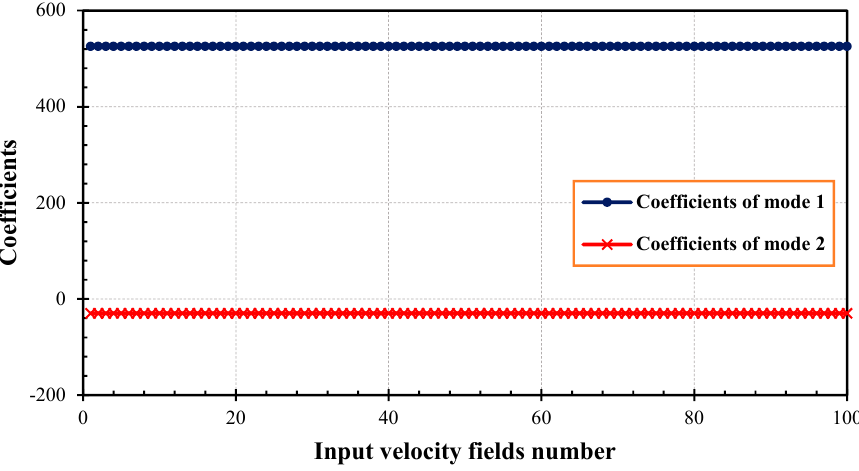
Figure 6. Coefficients of the first two POD modes for all 100 input velocity vector fields.